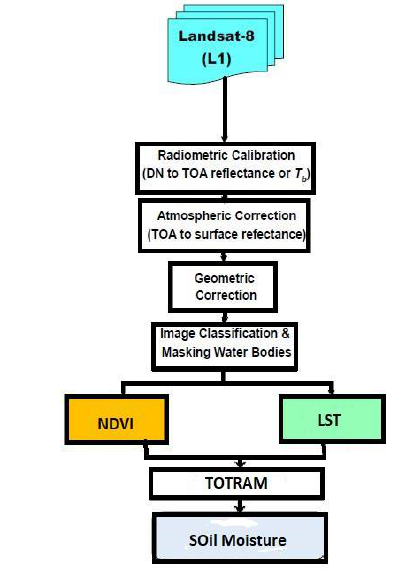
Figure 2. Flowchart of the used method